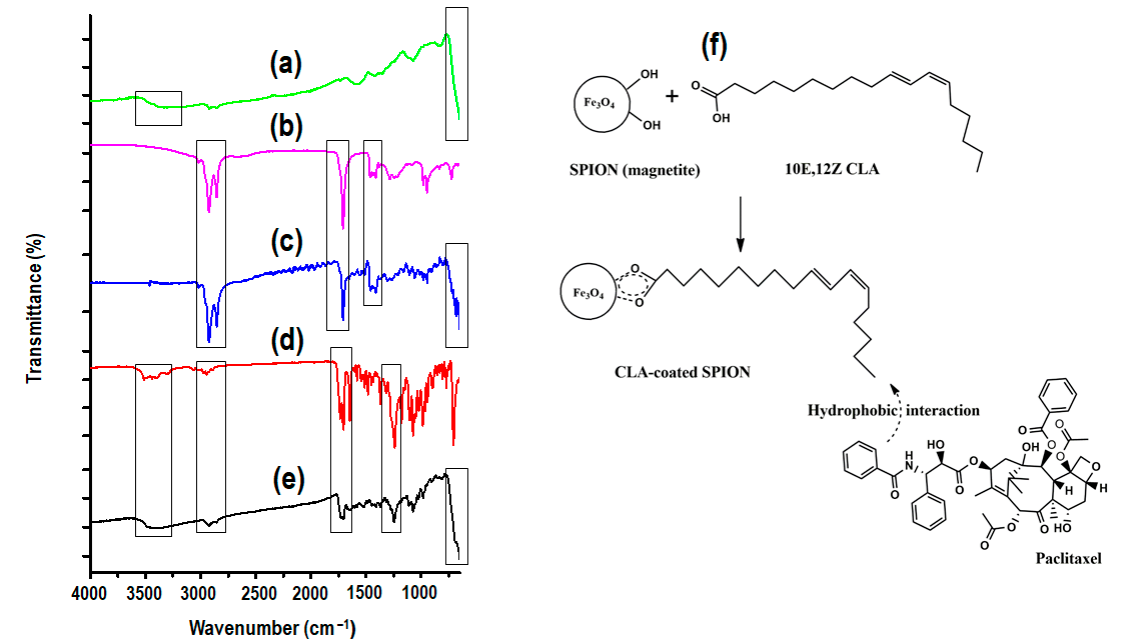
Figure 2. FT-IR spectra of ( a ) pristine SPIONs, ( b ) pristine CLA, ( c ) CLA-coated SPIONs, ( d ) pristine PTX, ( e ) CLA-coated PTX-SPIONs, and ( f ) schematic representation of CLA chemisorption onto SPIONs and CLA-PTX hydrophobic interaction.